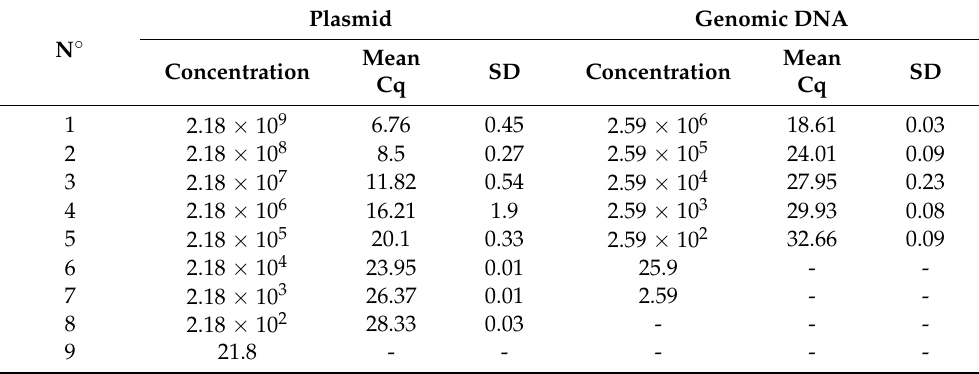
Table 5. Detection sensitivity of the test plasmid and genomic